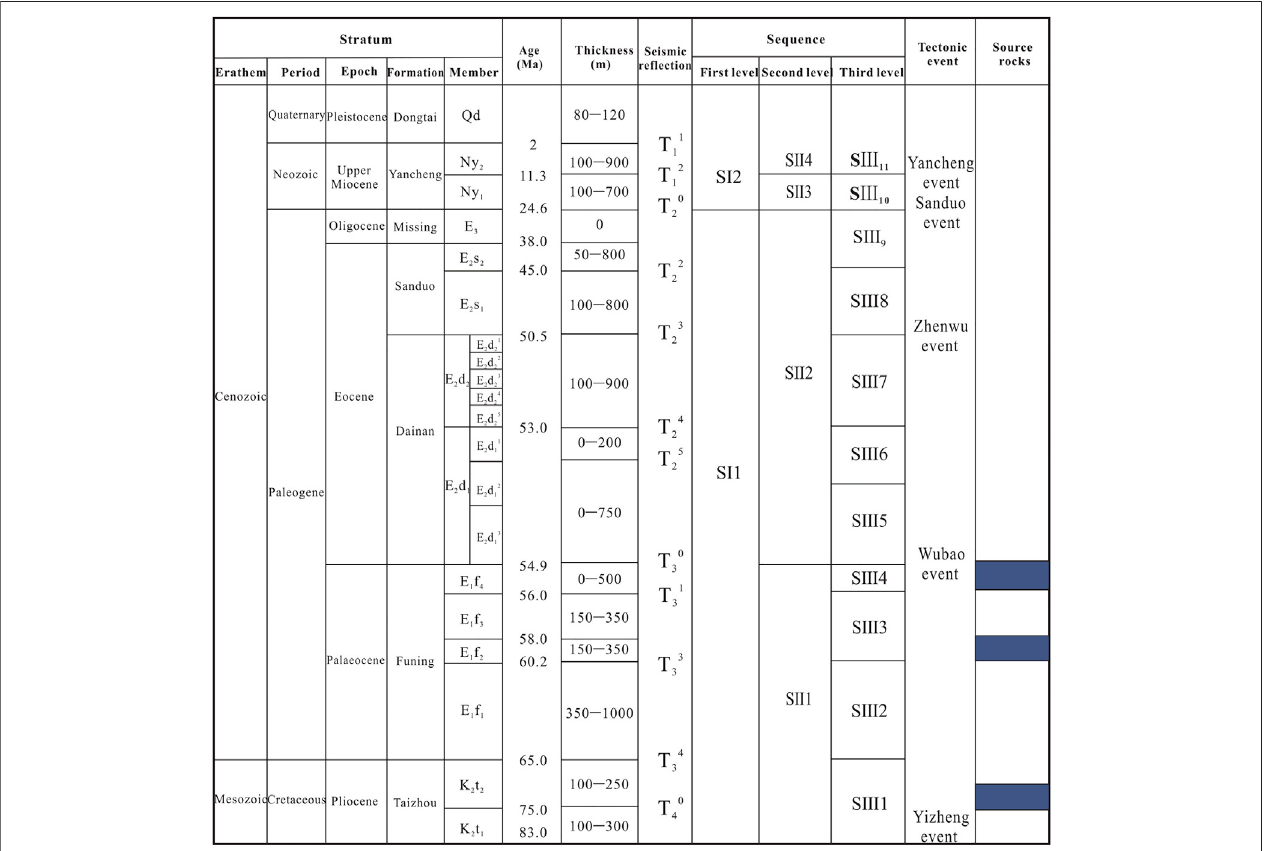
FIGURE 3 | Comprehensive stratigraphic column showing the major tectonic events and sedimentary sequences in the Subei Basin. Yizheng and Wubao movements controlled the formation evolution of the Gaoyou sag.